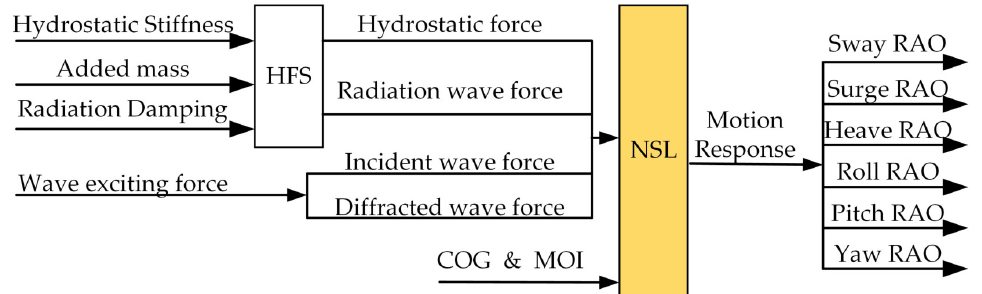
Figure 6. The numerical computation progress of motion